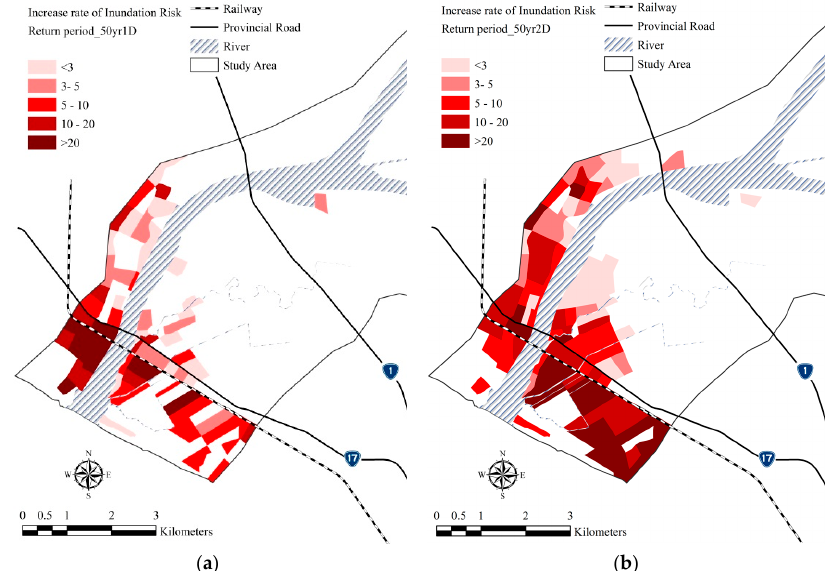
Figure 16. ( a ) Distribution map of inundation risk increase after land subsidence and A1B-S scenario for a one-day storm under a 50-year return period; ( b ) Distribution map of inundation risk increase